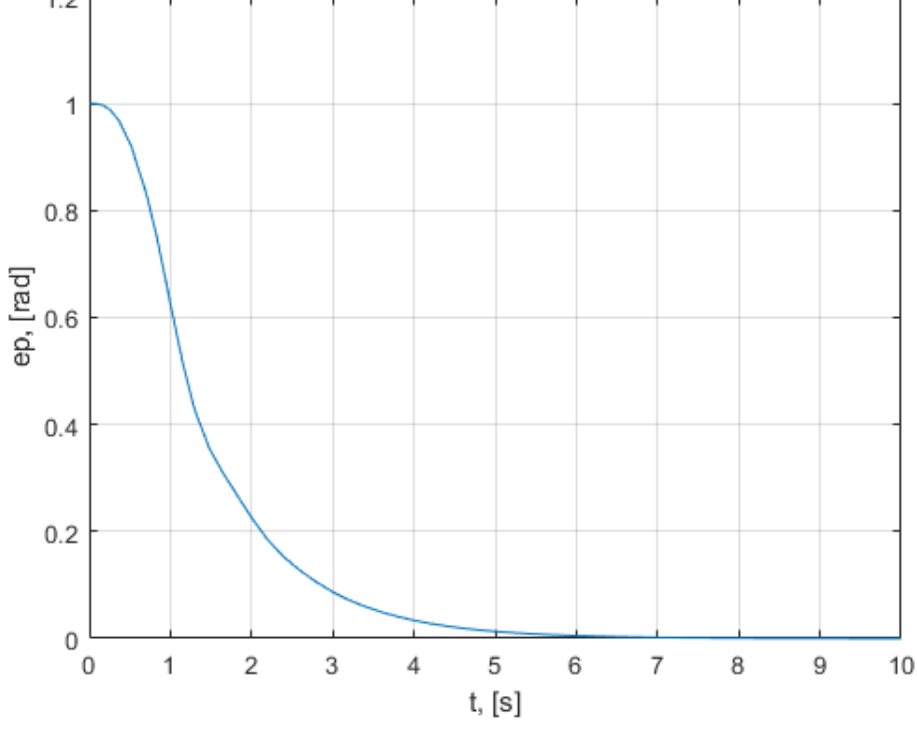
Figure A10. Position error.